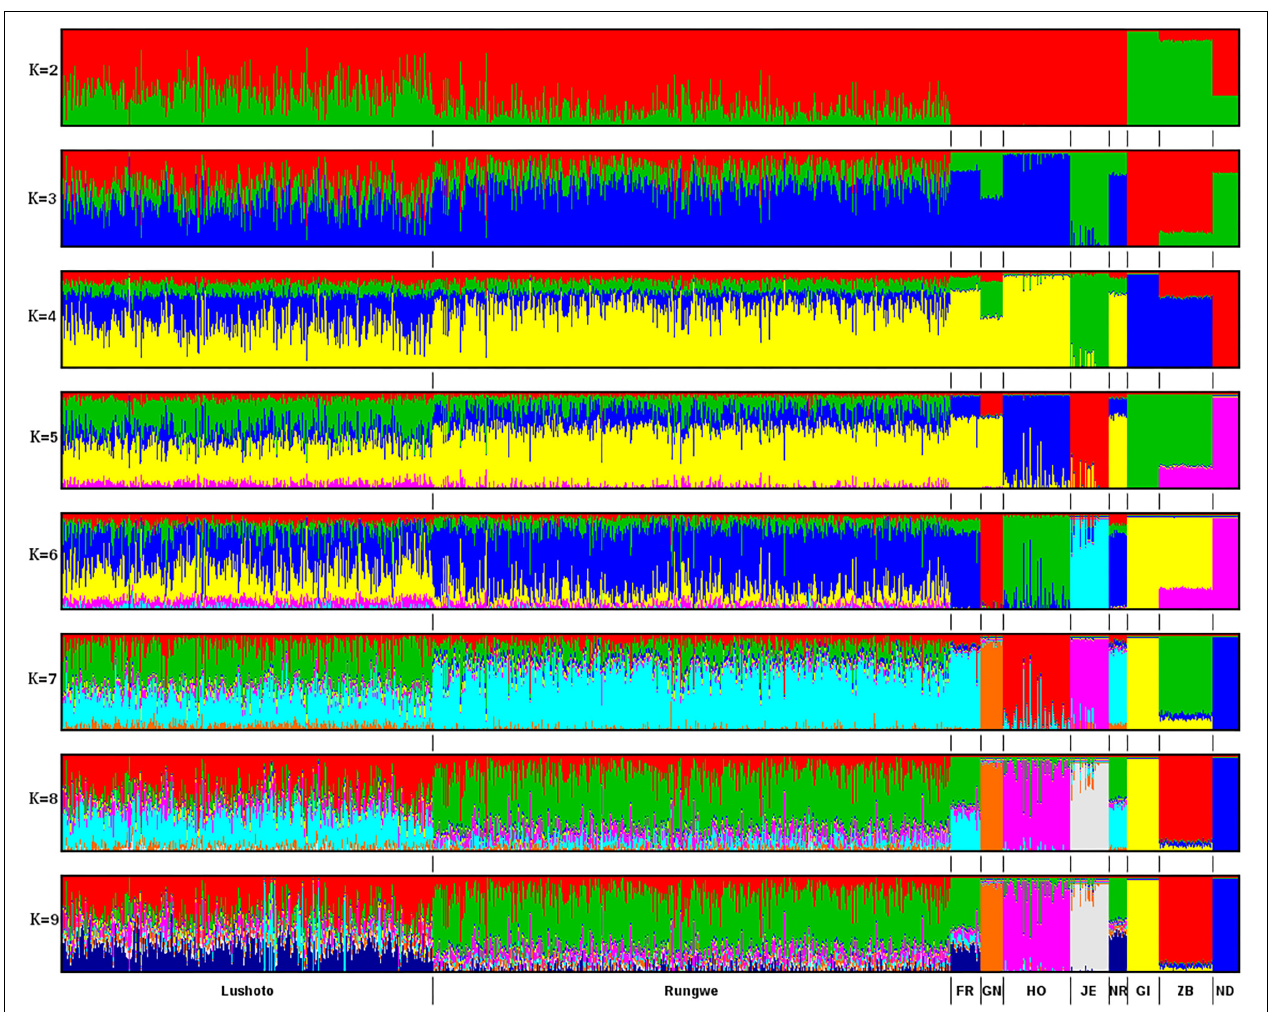
FIGURE 2 | ADMIXTURE bar plots of breed proportions ( K = 2 to K = 9), with K representing the optimal number of discrete breeds. Each animal is represented by a vertical line divided into K colored segments representing the estimated fraction belonging to each cluster. Short vertical lines at the bottom of each horizontal bar delimit individuals of different populations. Tanzania cattle populations are divided according to the sampling locations, Lushoto and Rungwe, respectively. Reference breeds are labeled as Friesian (FR), Guernsey (GN), Holstein (HO), Norwegian Red (NR), Jersey (JE), Gir (GI), Zebu (ZB), and N’Dama